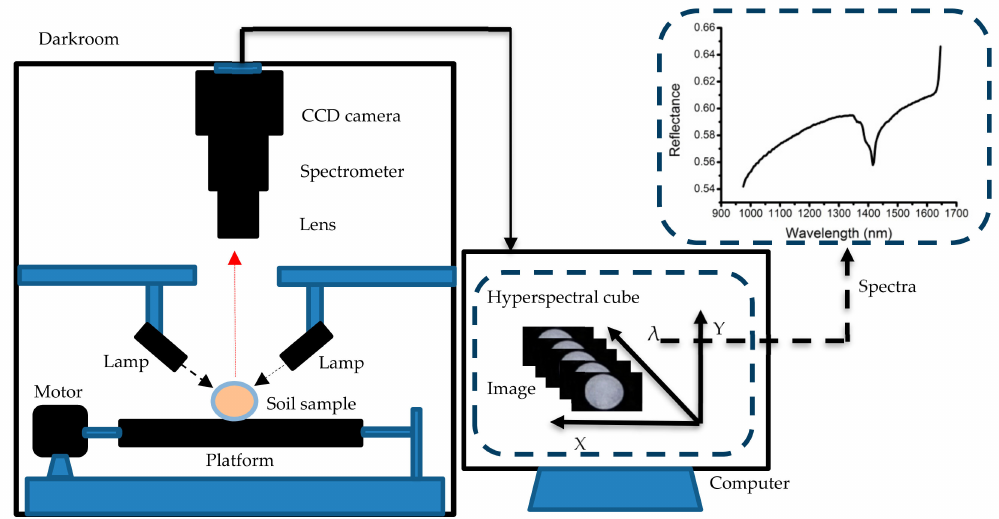
Figure 2. The hyperspectral imaging (HIS)